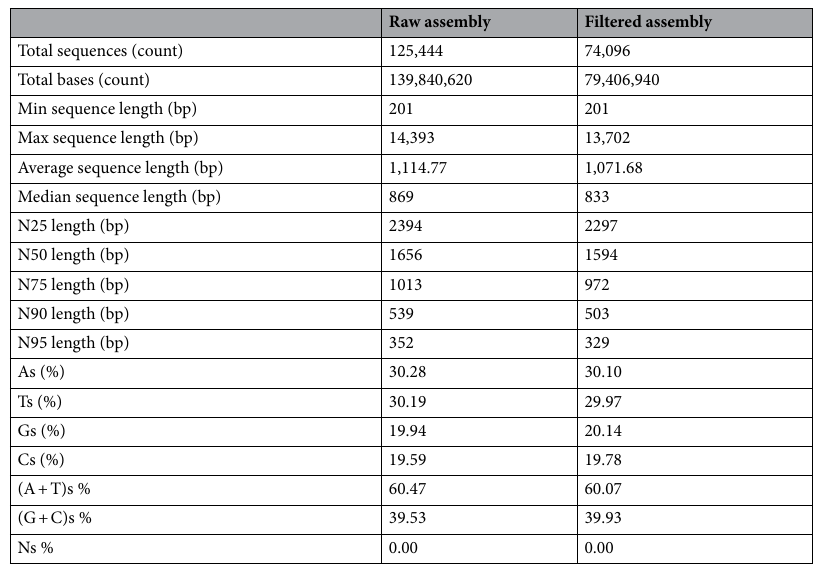
Table 2. Statistics of the transcriptome